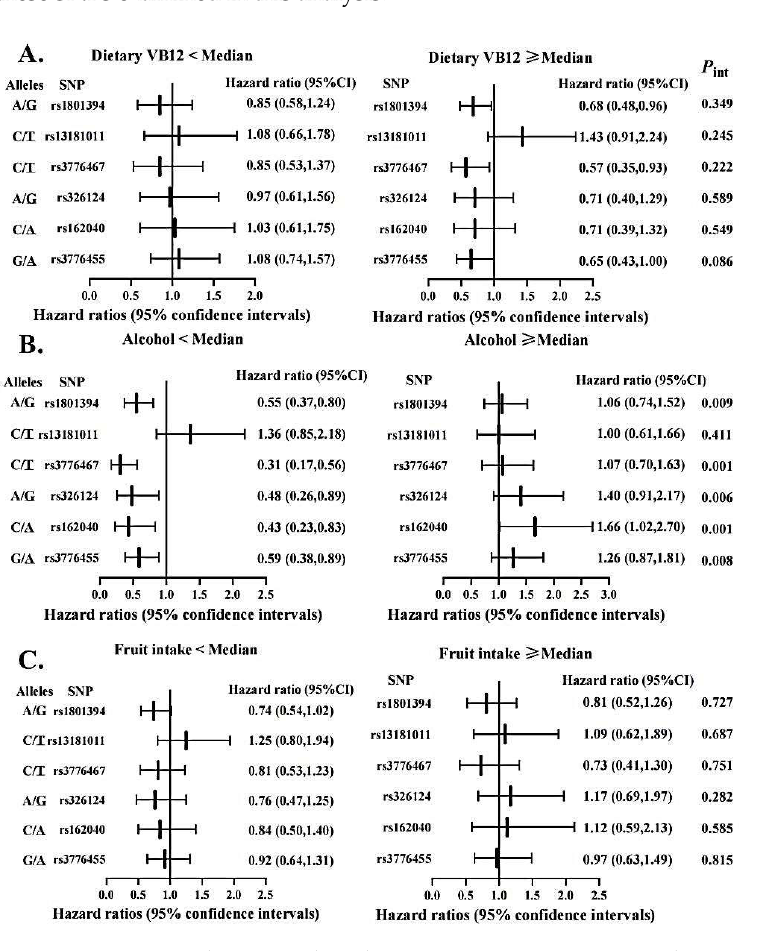
Figure 3. Association between selected genetic variations in MTRR and CRC overall survival stratified by dietary vitamin B12 ( A ), alcohol intake ( B ), and fruit consumption ( C ). Abbreviations: SNP = single nucleotide polymorphisms; VB12 = vitamin B12. Two variants at the locus presented as: Minor/Major allele. Hazard ratios were calculated in reference to the allele underlined. Cox proportional hazard models were age at diagnosis, sex, stage at diagnosis, race, BMI, marital status and MSI status, where appropriate. The medians of dietary vitamin B12, alcohol drinking, and fruit intake were 7.30 µg/day, 2.17 g/day, and 7 pieces/week, respectively.